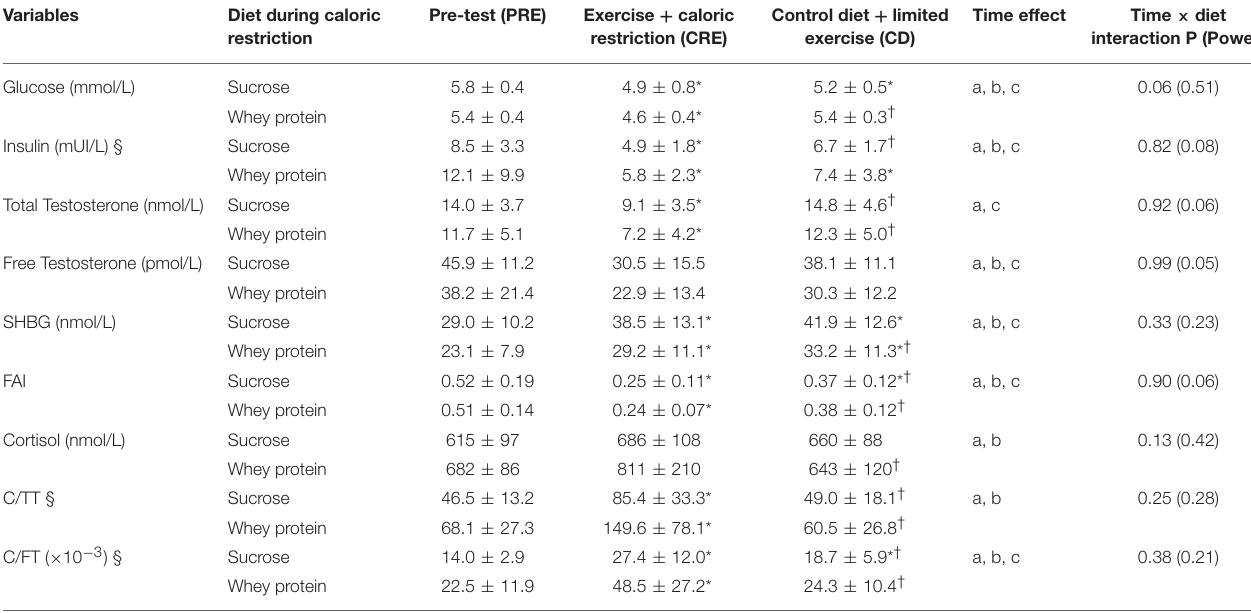
TABLE 4 | Changes in the plasma levels of glucose and hormones. Variables Diet during caloric Pre-test (PRE) Exercise + caloric Control diet + limited restriction restriction (CRE) exercise